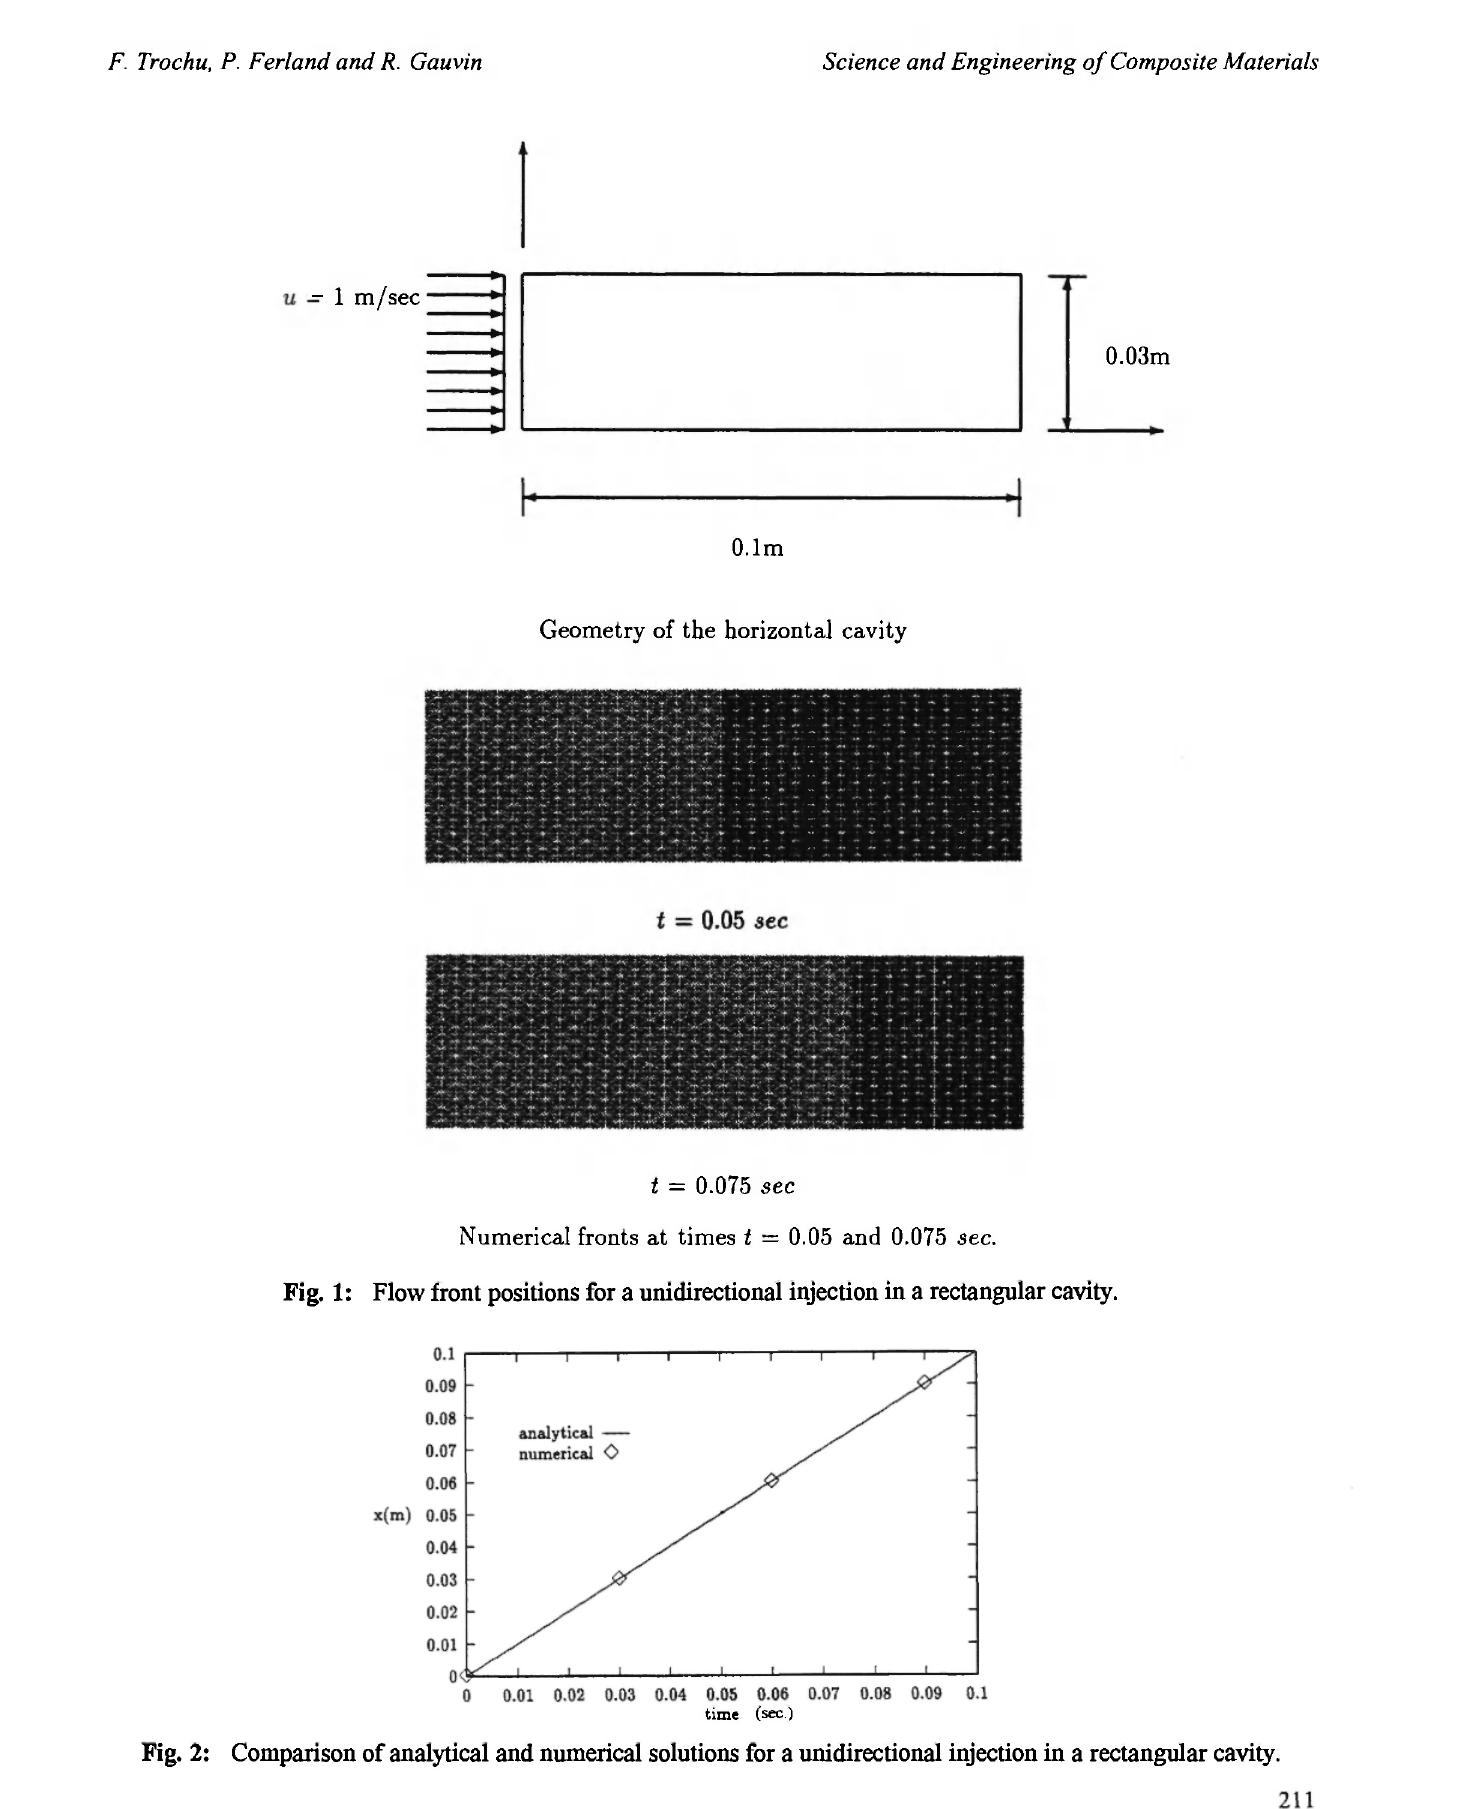
time (sec.) Fig. 2: Comparison of analytical and numerical solutions for a unidirectional injection in a rectangular